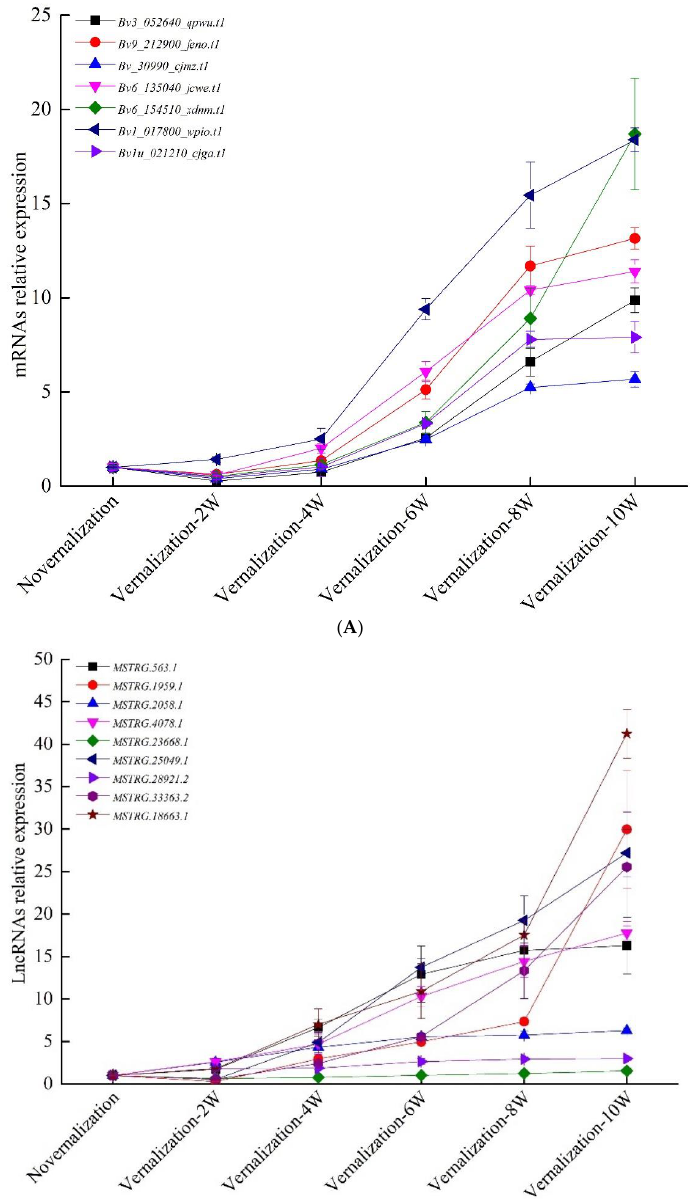
Figure 7. Quantitative real-time polymerase chain reaction (qRT-PCR) analysis at time point (i.e., vernalization at 0, 2, 4, 6, 8 and 10 weeks). The qRT-PCR results for ( A ) differentially expressed mRNAs; ( B ) differentially expressed long-coding RNAs. BvICDH was used as the internal control. Error bars, mean ± s.e. ( n = 3).